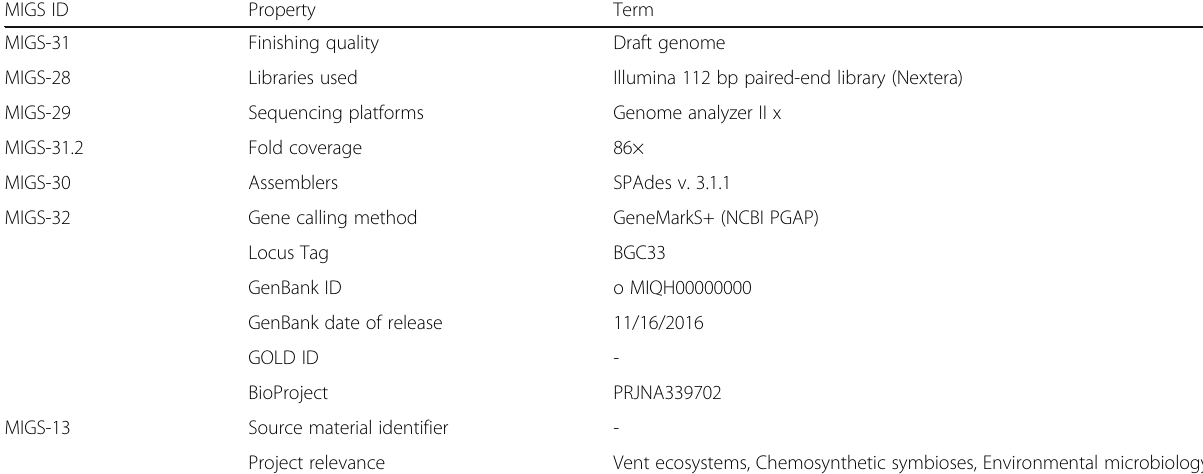
Table 2 Project information